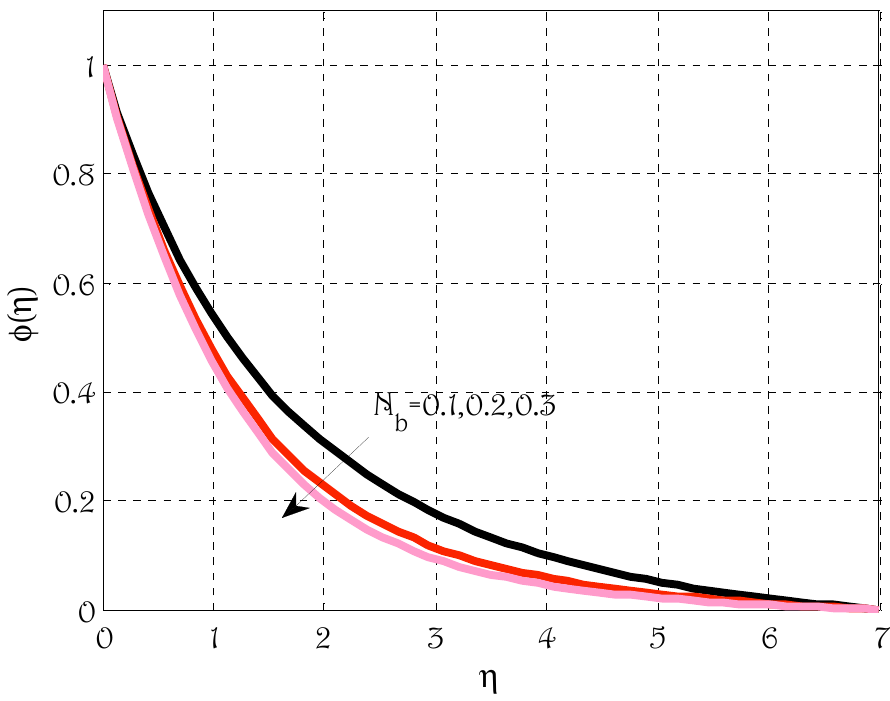
Figure 12. Effect of Brownian motion parameter N b on concentration profile φ using k p = 0.5, M = 0.5, E c = 0.4, λ = 0.1, S c = 1.4, N t = 0.1, P r = 1.5, R d = 0.7, γ = 0.1.